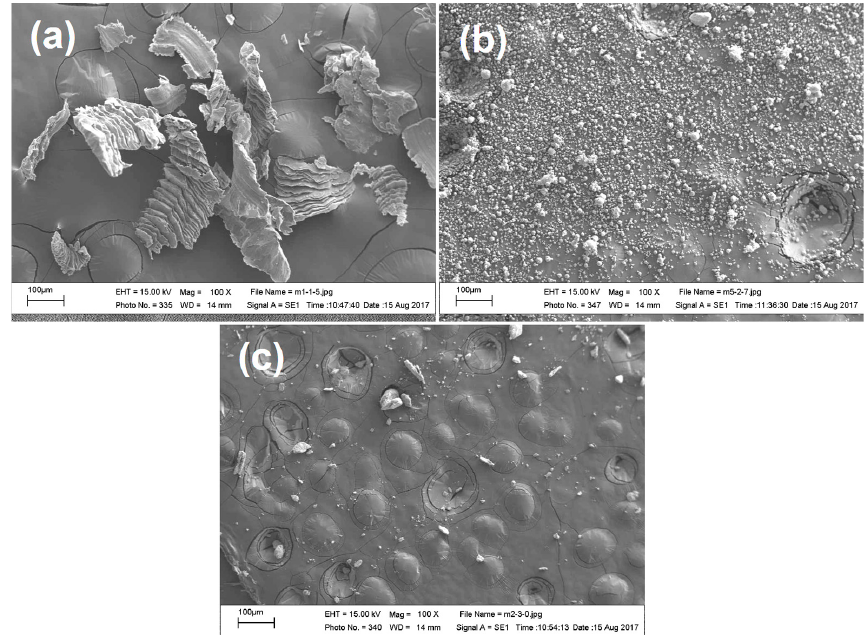
Figure 1. Initial powders of ( a ) Mg, ( b ) Zn, and ( c ) Ca. Reprinted from Ref. [25]. Physics SRL, 2021. During grinding, a very fine mixture of the components is formed. This mixture is most often lamellar in the case of ductile metal powders. Obtaining the alloy itself is me- diated by the defects at the level of a crystalline lattice (dislocations, stacking faults, va- cancies, etc.) formed as a result of severe cold plastic deformation. These defects facilitate rapid diffusion while also leading to a slight increase in powder temperature during mill- ing due to frictional forces and the impact between the milling balls and the surface of the container. Suryanarayana [32] also explained that the necessary energy is obtained to reach a homogeneous microstructure of powder particles with the same composition as the proportion of the constituent powders because of the repeated severe plastic defor- mations of the powder particles, which are cold-welded and constantly fractured after- ward. Figures 2 and 3 display the particle size and morphology variation as the milling time increases for the Mg65–Zn30–Ca5 and Mg70–Zn25–Ca5 powder mixtures, respec- tively. The SEM micrographs (Figures 2 and 3) of the Mg65–Zn30–Ca5 and Mg70–Zn25– Ca5 powder mixtures after 15 h of milling displayed two types of distortion mechanisms characteristic of the MA process that happened during milling: ductile deformation, which forms flatter and longer particles linked to the deformation experienced by Mg during the first hours of milling, and brittle deformation, which results in the creation of particles with a more angular and irregular morphology typical of brittle materials. Duc- tile deformation, which results in the formation of larger particles, has been reported by Abdoli [33]. The powder mixtures subjected to 15 and 20 h of milling (Figures 2 and 3) showed that the particle size decreased compared with the samples milled for 15 h. In addition, the particle shape became irregular, indicating that the brittle fracture was pre- dominant because of the hardening due to the deformation exhibited in both composi- tions.